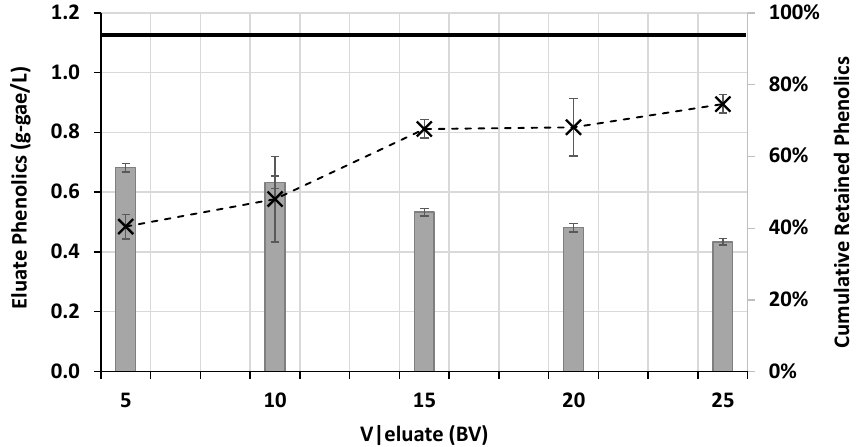
Figure 3. Total phenolic compounds (TPC) in the eluate (x, dashed line ) and corresponding percentage of phenolics cumulative retention (column) in the HP-20 resin for the different eluted volumes ( V|eluate ). Solid line marks the maximum amount of phenolic compounds, considering the eluted feed.